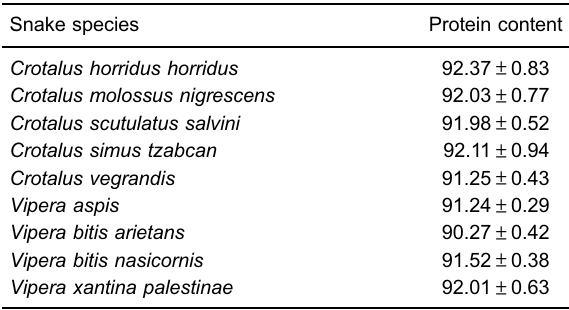
Table 1. Total protein content of freeze-dried venom samples of snake